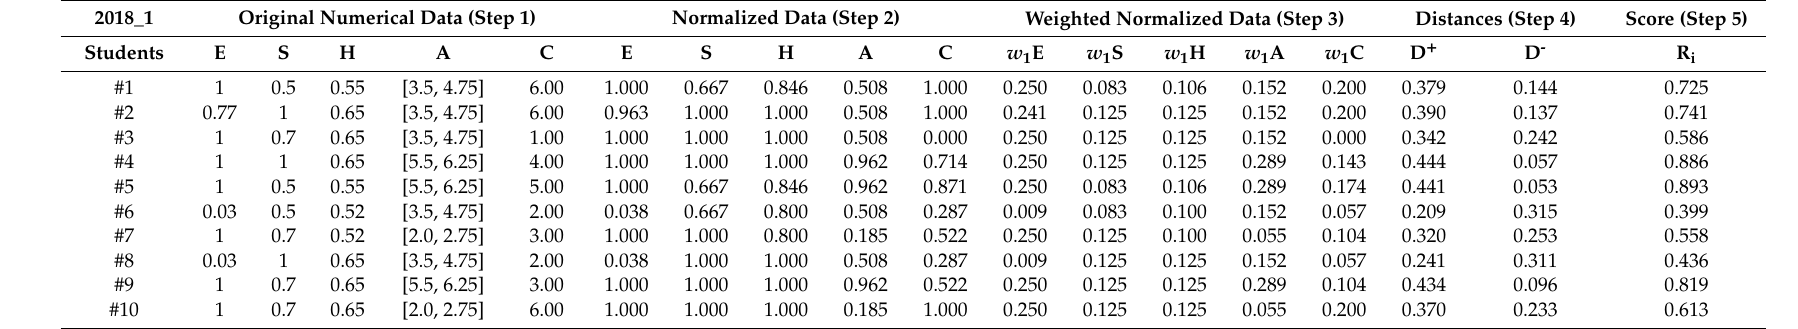
Table A1. Steps of the Technique for Order of Preference by Similarity (TOPSIS)